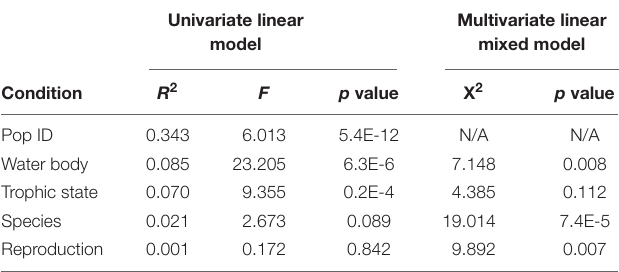
Multivariate linear mixed